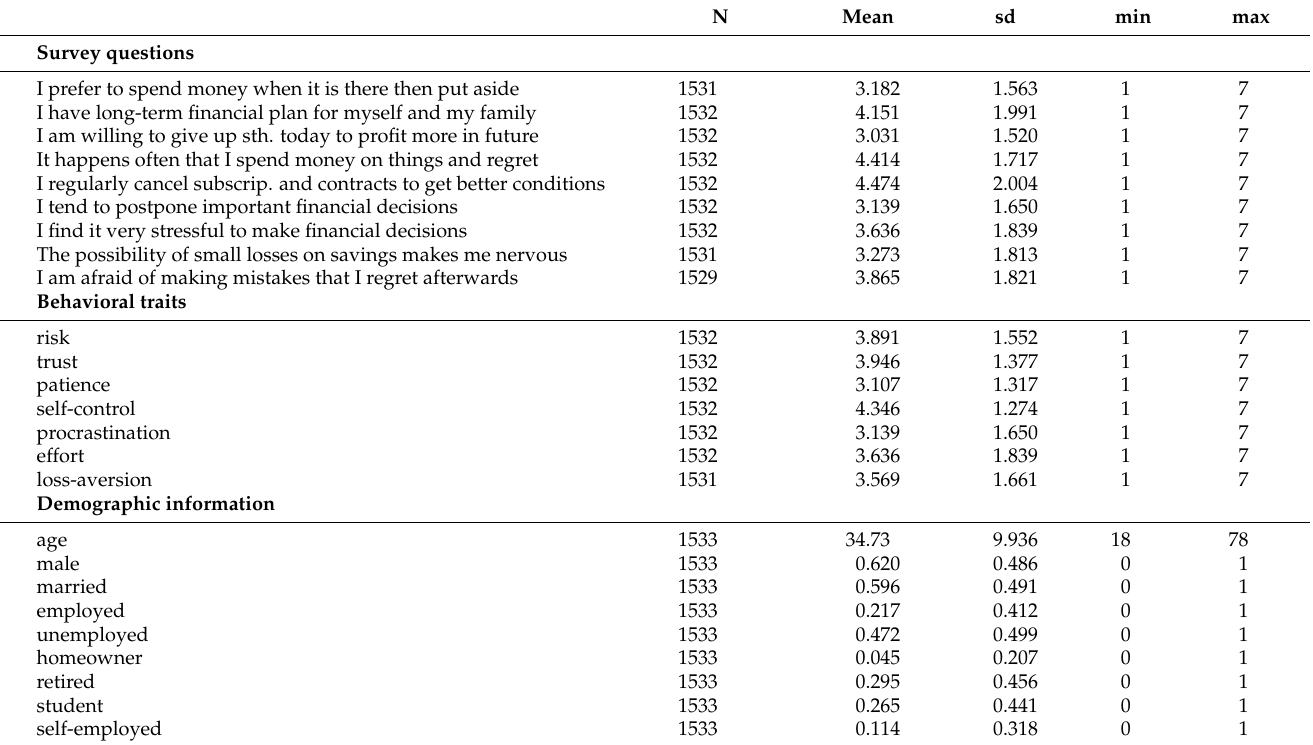
Figure A8. Marginal effects of all covariates in the full model. Note: Here, we display the average marginal effects of all covariates that base on the probit regression from Equation (1) where we regressed a dummy that is 1 if an individual holds crypto-assets, and 0 if not. Source: Own data. Table A3. Descriptive statistics of survey and demographics. Source: Own